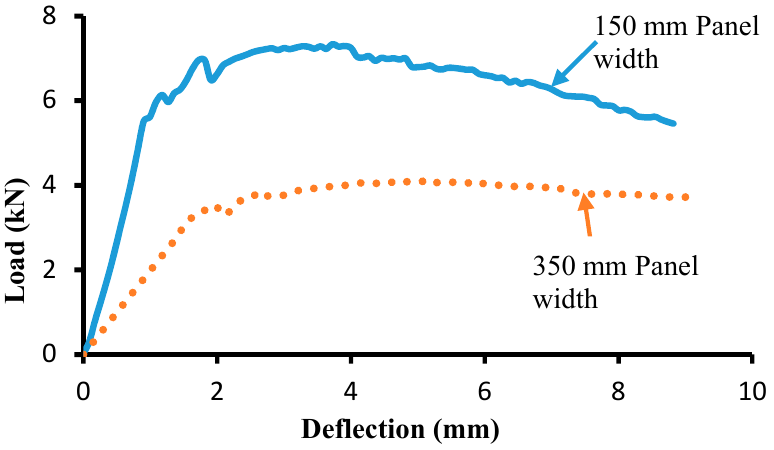
Figure 9. Effect of UHPC panels width on the flexural strength.